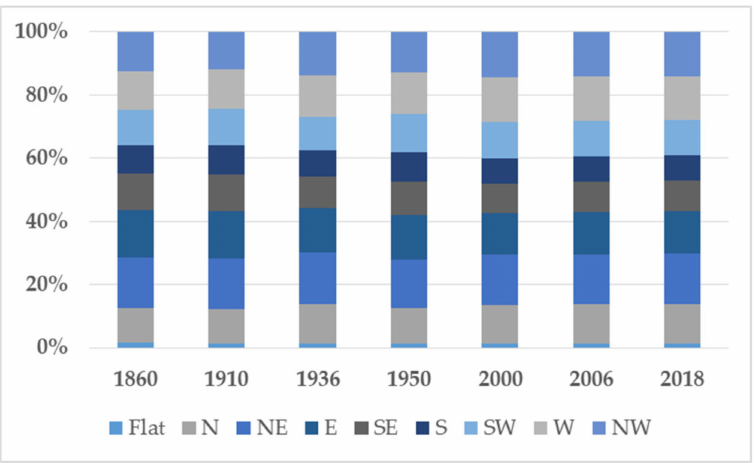
Figure 7. Frequency distribution histograms (%) for each orientation